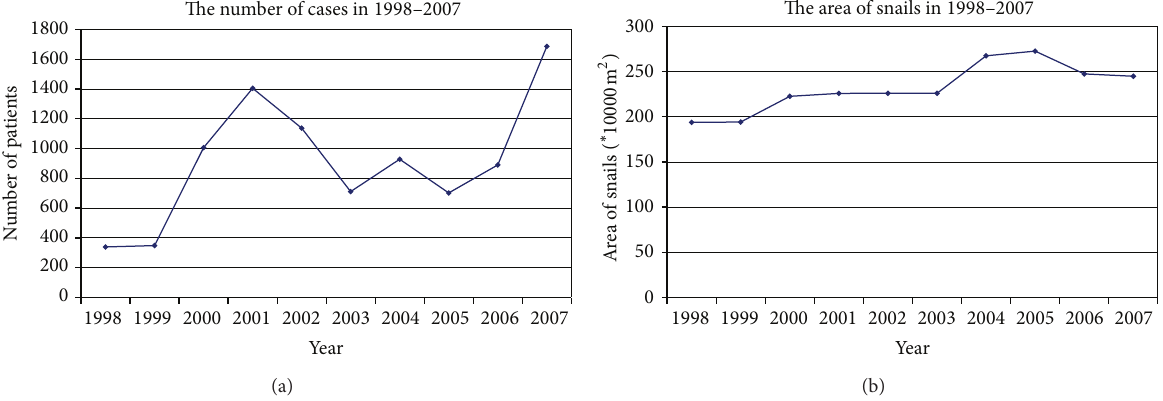
Figure 1: The observation data in Tongcheng city from Tongcheng Schistosomiasis Control Station in